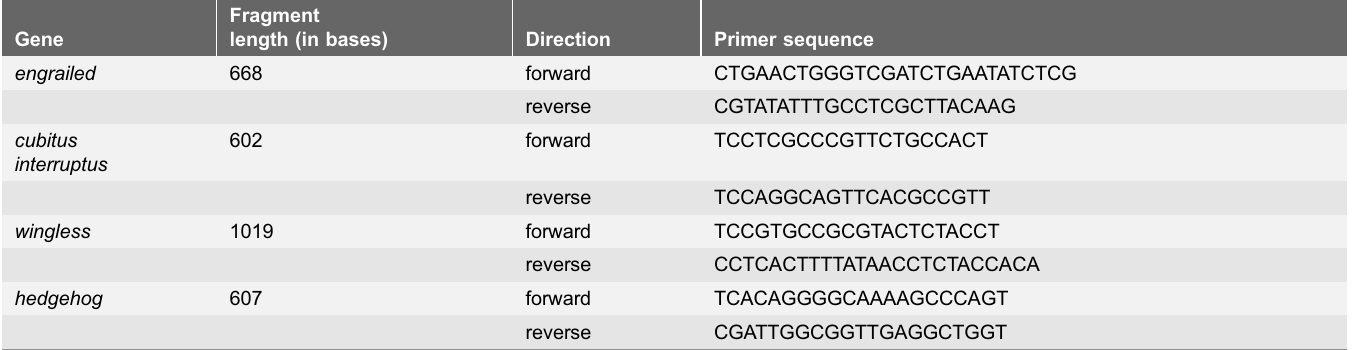
Table 1. Specific primers used for